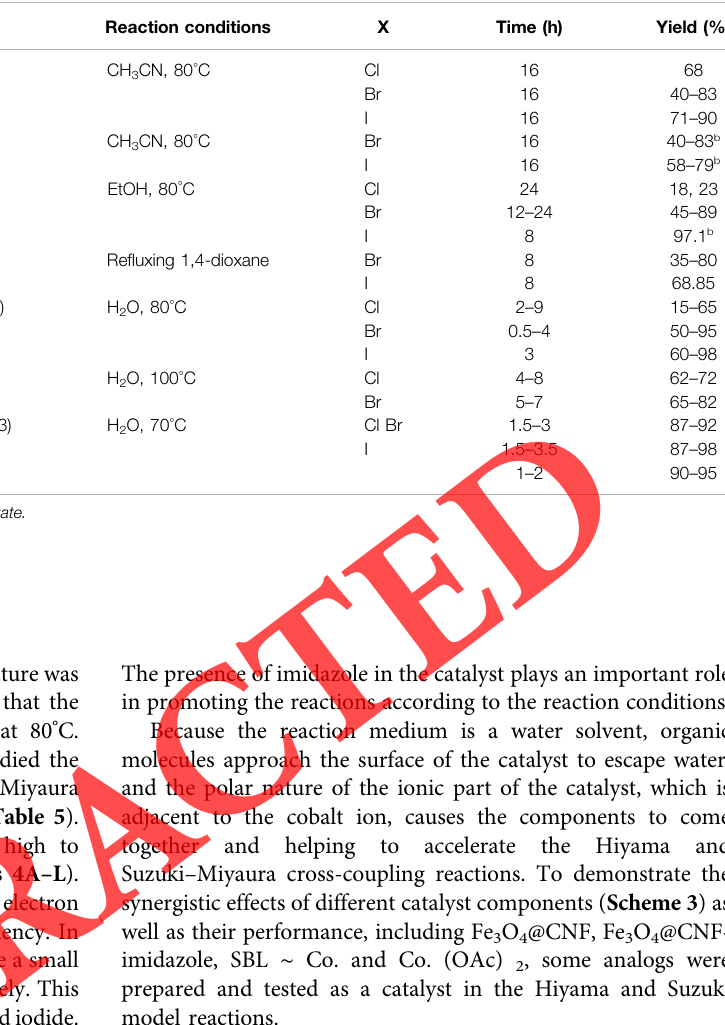
TABLE 6 | Comparison of catalytic activity of Fe 3 O 4 @CNF ∼ ImSBL ∼ Co. catalyst with some reported cobalt catalysts for Suzuki – Miyaura cross-coupling